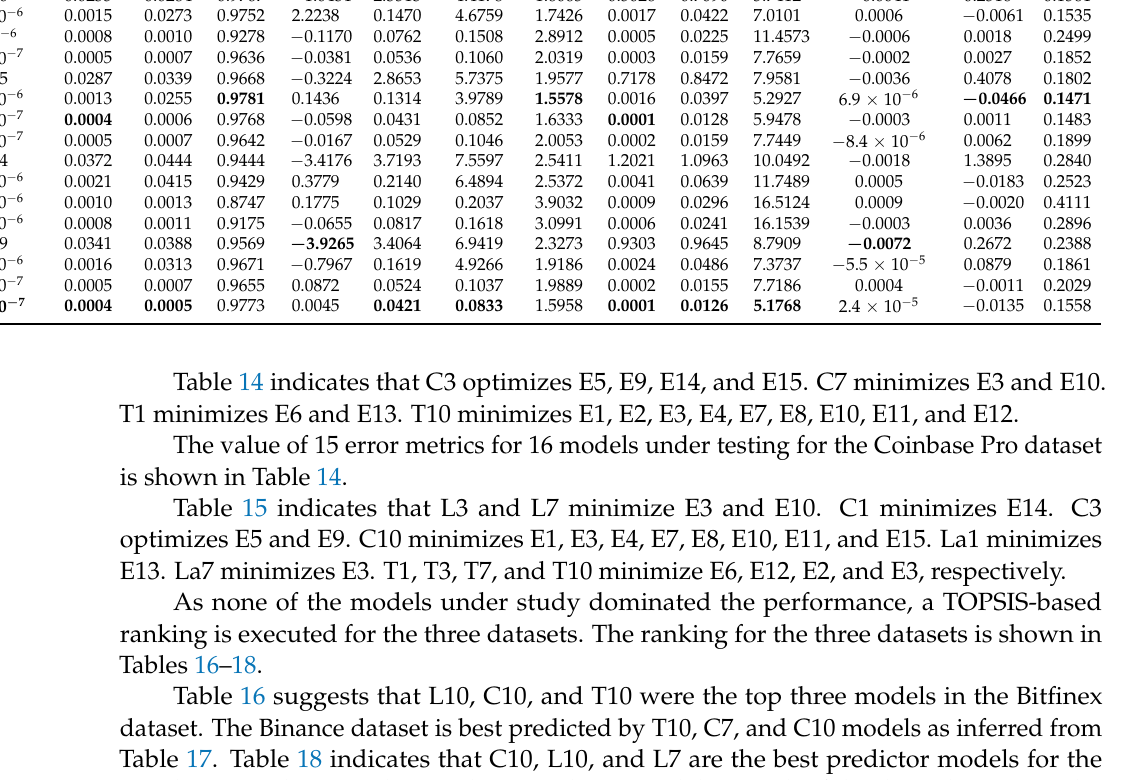
Table 17. Table 18 indicates that C10, L10, and L7 are the best predictor models for the Coinbase Pro dataset. The top three predictor models in each of the three datasets under study are represented in Table